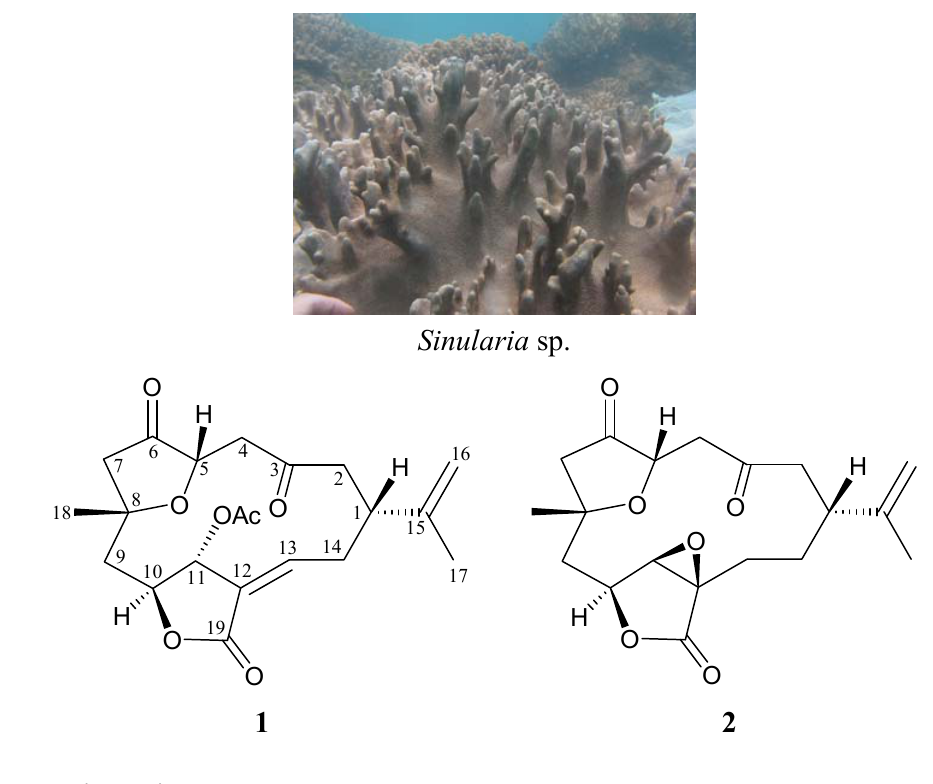
Figure 1. The soft coral Sinularia sp. and the structures of 5-episinuleptolide acetate ( 1 ) and scabrolide D ( 2 ).